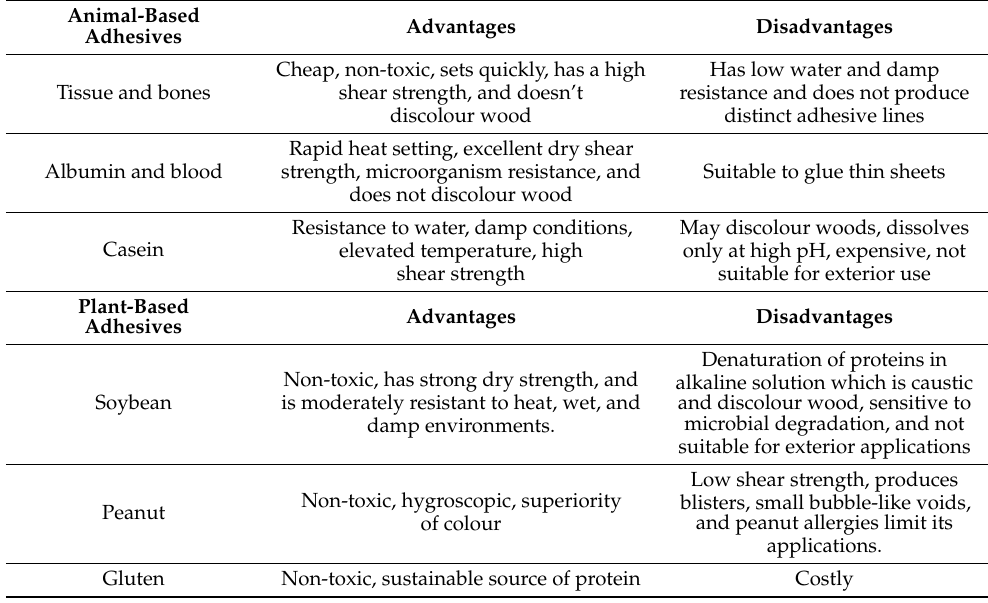
Table 3. Different Animal and Plant Protein-based Adhesives [38]. Animal-Based